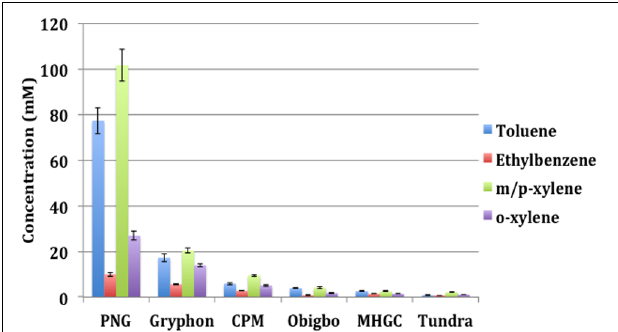
FIGURE 1 | Concentrations of alkylbenzenes determined by gas chromatography-mass spectrometry (GC-MS) analysis of oil samples used in this study. Error bars represent standard deviations for duplicate